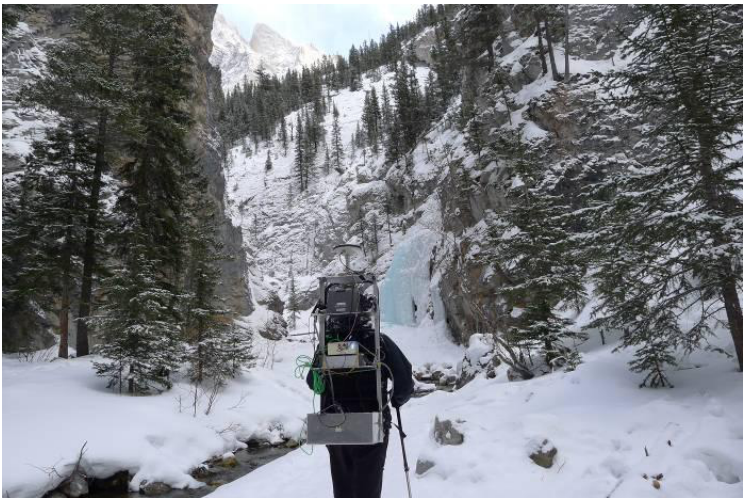
Figure 6. Data collection environment (natural